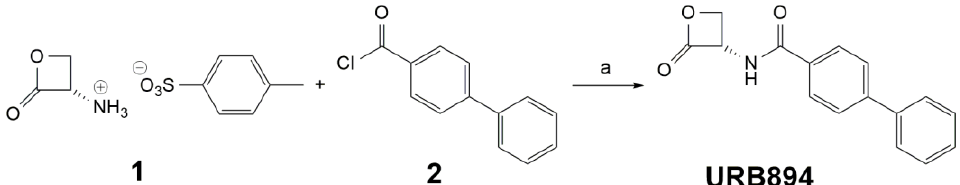
Figure 2. Reagents and conditions: (a) Et 3 N, THF, 0 °C, 0.5 h, then rt, 3 h.